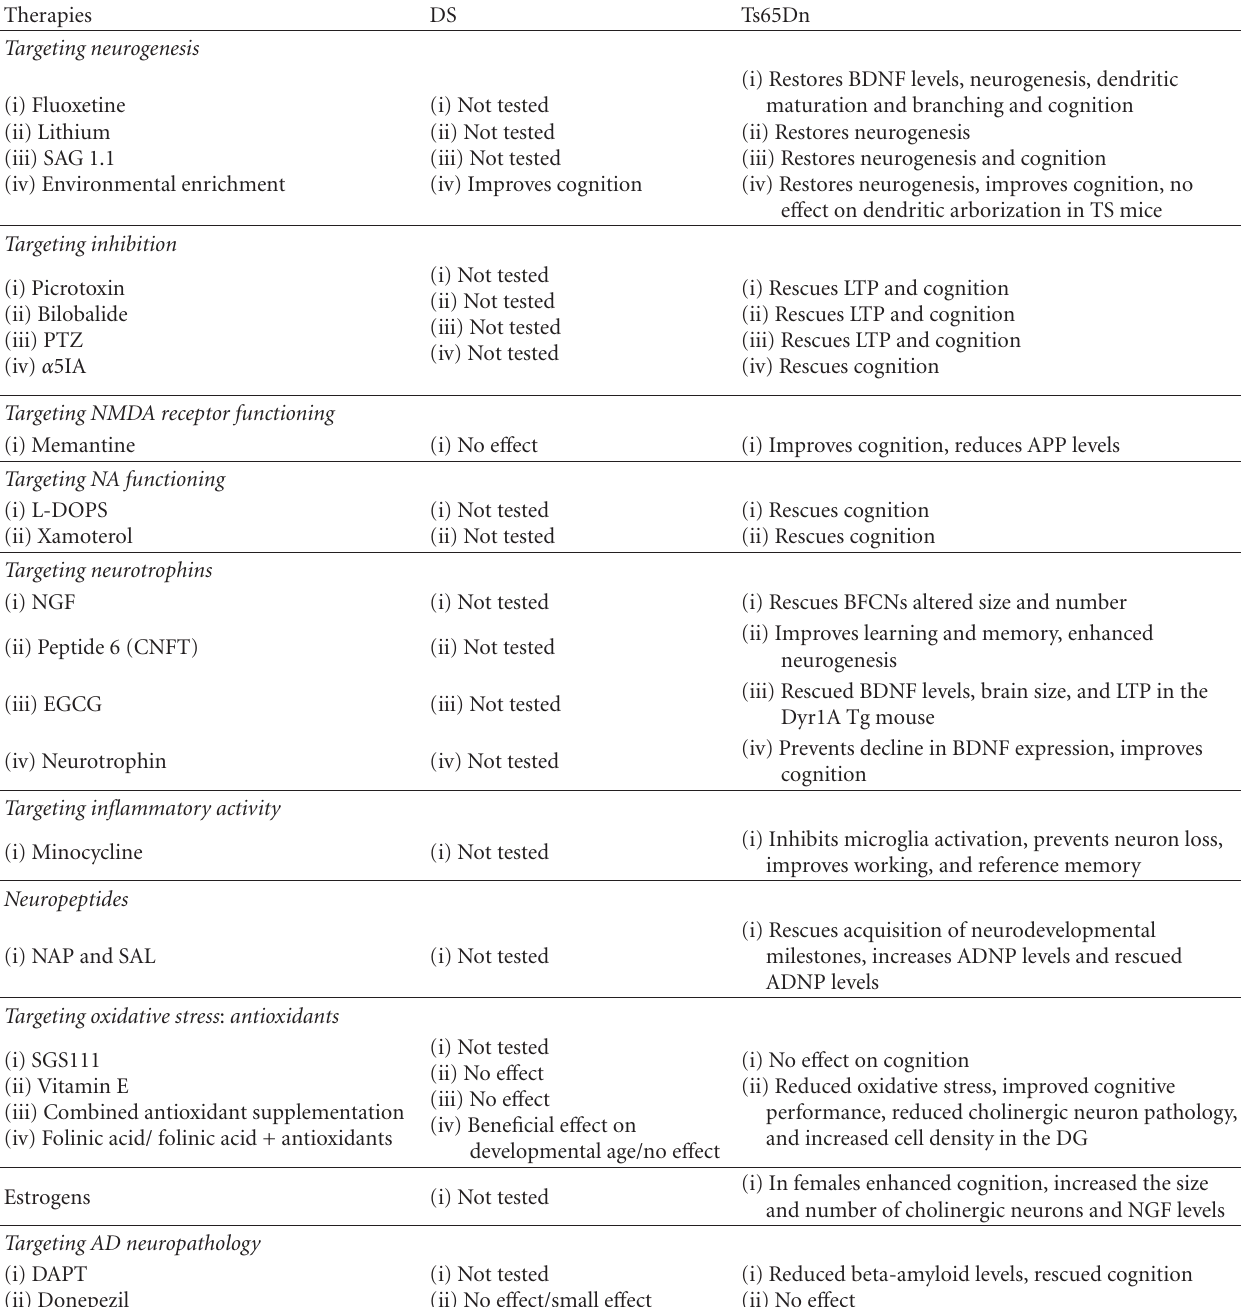
Table 3: Therapeutical approaches tested in DS and in the Ts65Dn